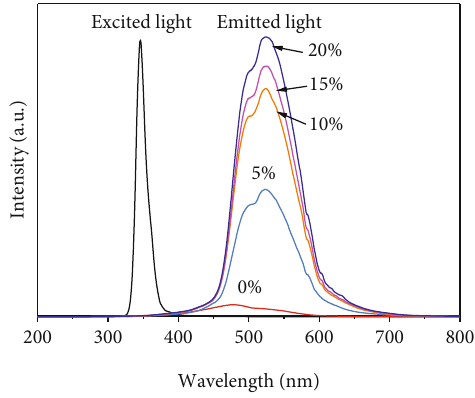
Figure 5: PL spectra of phosphor-in-glass ceramic aggregates with varying phosphor